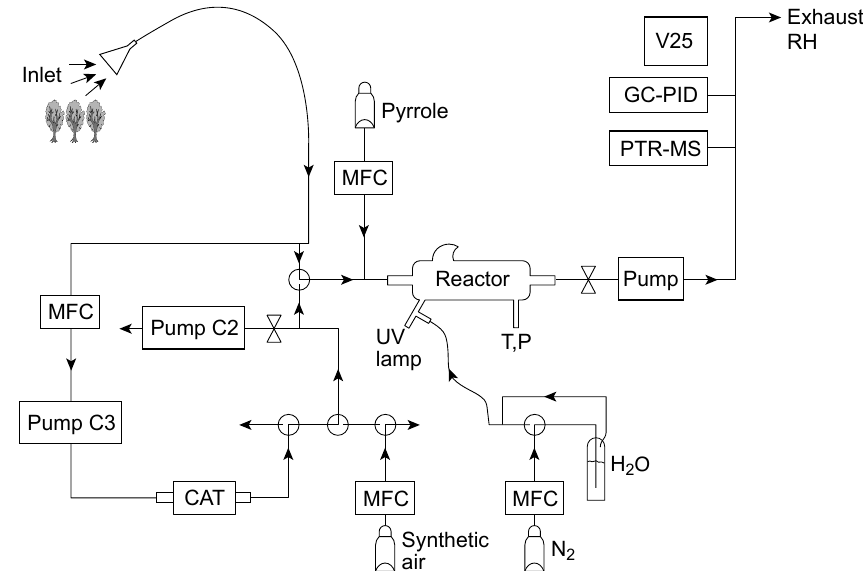
Fig. 5. Schematic of the Comparative Reactivity Method (CRM), as it was set up for all presented tests and field campaigns. Two detectors (PTR-MS, GC-PID) were probing in parallel the outflow of the reactor. Mass flow controllers (MFC), valves and a catalytic converter (CAT) were operated by a controlling devise V25. This also recorded the measurement positions (C1, C2, C3) as well as temperature ( T ) and pressure ( P ) inside the system and relative humidity